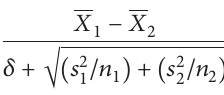
denotes the proportion of 𝜋𝜋 1